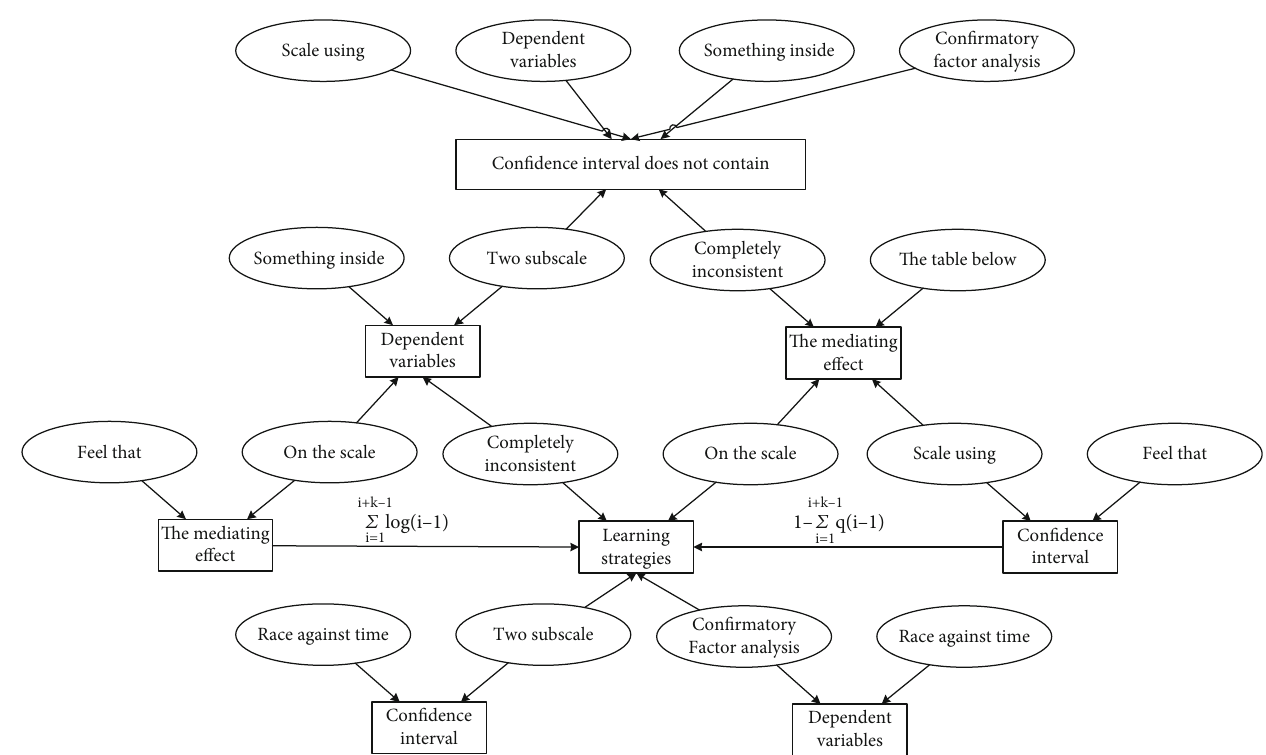
Figure 4: Analysis of the mediation e ff ect of job